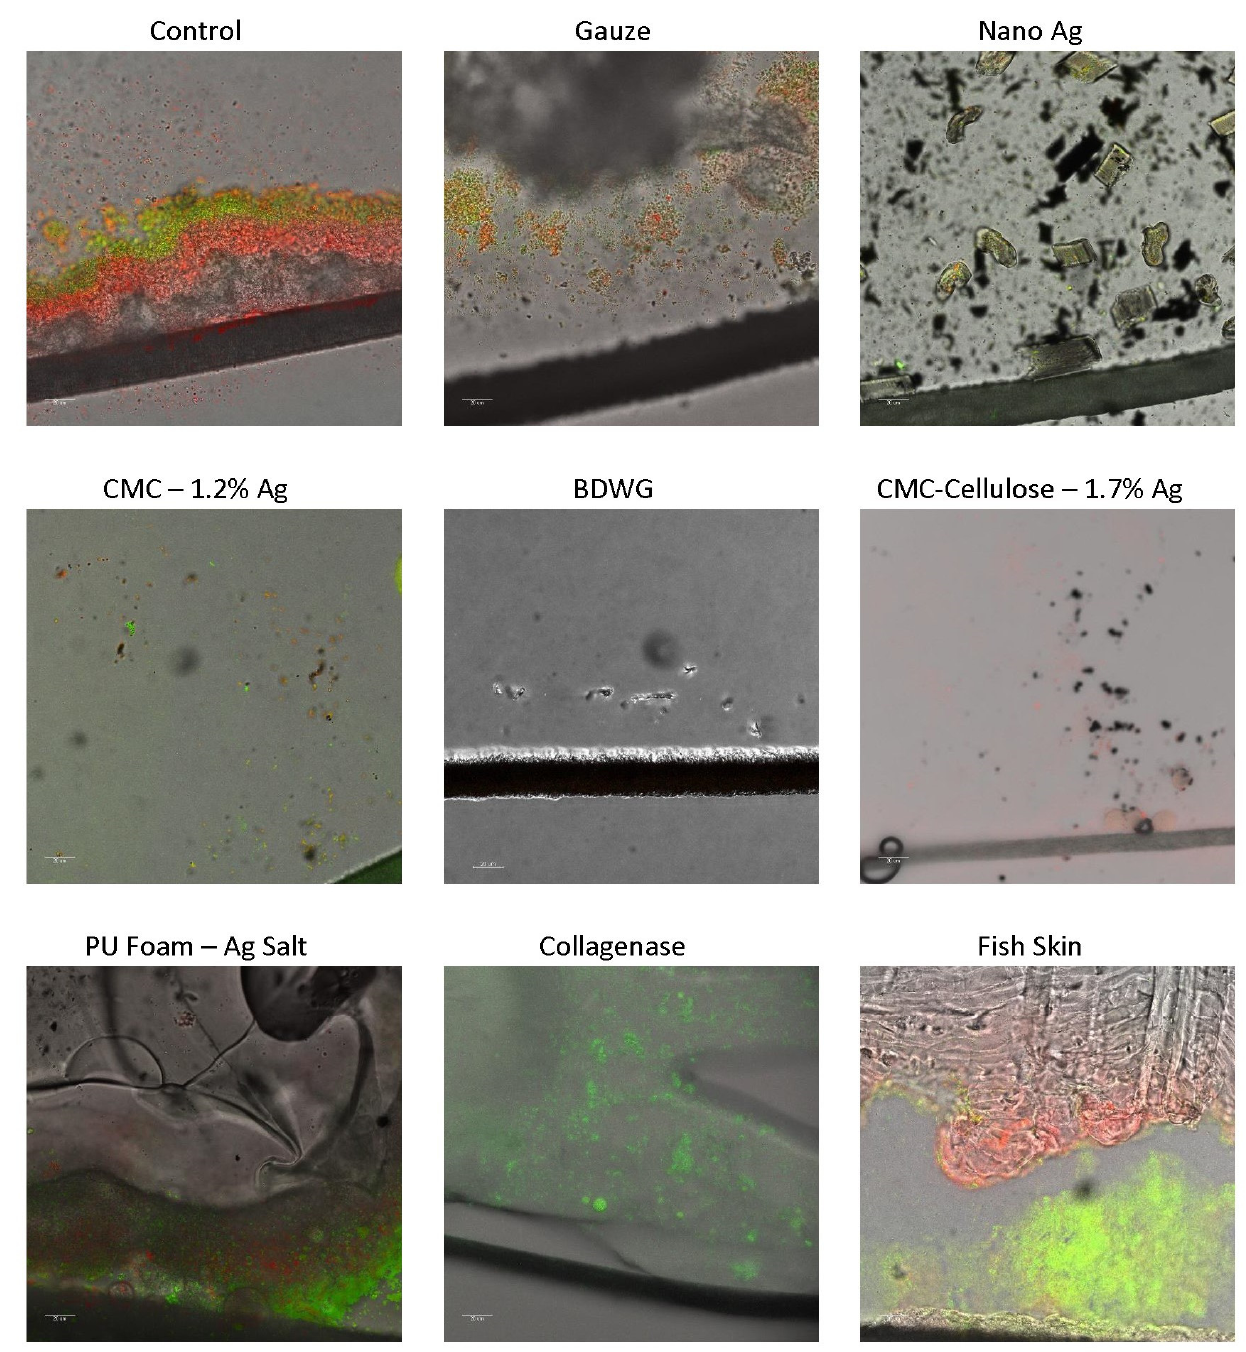
Figure 3. CSLM images of LIVE/DEAD™ stained cryosections from membrane/dressing pairs after the 24 h treatment period overlaid with transmitted light images. The black line near the bottom of the images is the biofilm support membrane.